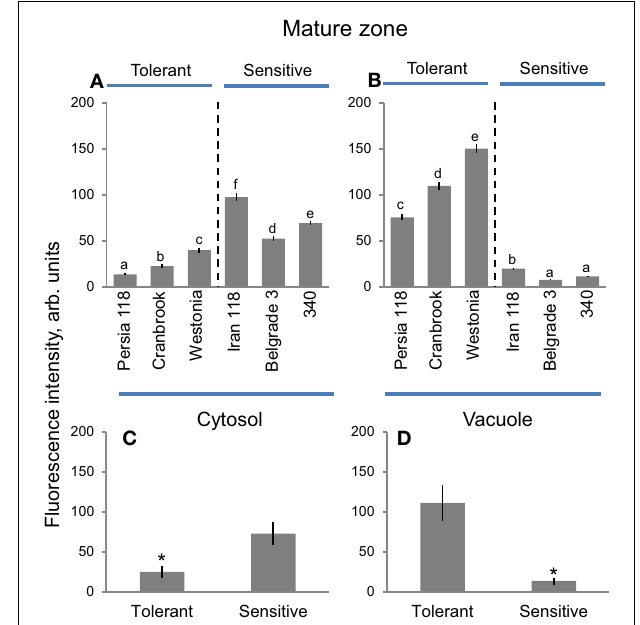
FIGURE 10 | Na + accumulation and patterning between cytosol and vacuole in mature root zone in bread wheat genotypes. Intensity of CoroNa Green fluorescence in cytosolic (A) and vacuolar (B) compartments (arb. units) in mature root zone of six bread wheat varieties contrasting in their salinity tolerance. Mean ± SE ( n = 72–96 cells from at least six individual plants). Different lowercase letters represents significant difference between varieties at P < 0 . 05. (C,D) Averaged pooled values for cytosolic (C) and vacuolar (D) Na + intensity for salt-tolerant and salt-sensitive clusters shown in A , B . Mean ± SE ( n = 240–320; three varieties × 72–96 cells analyzed for each variety). Asterisk indicates significant difference between clusters at P < 0 .